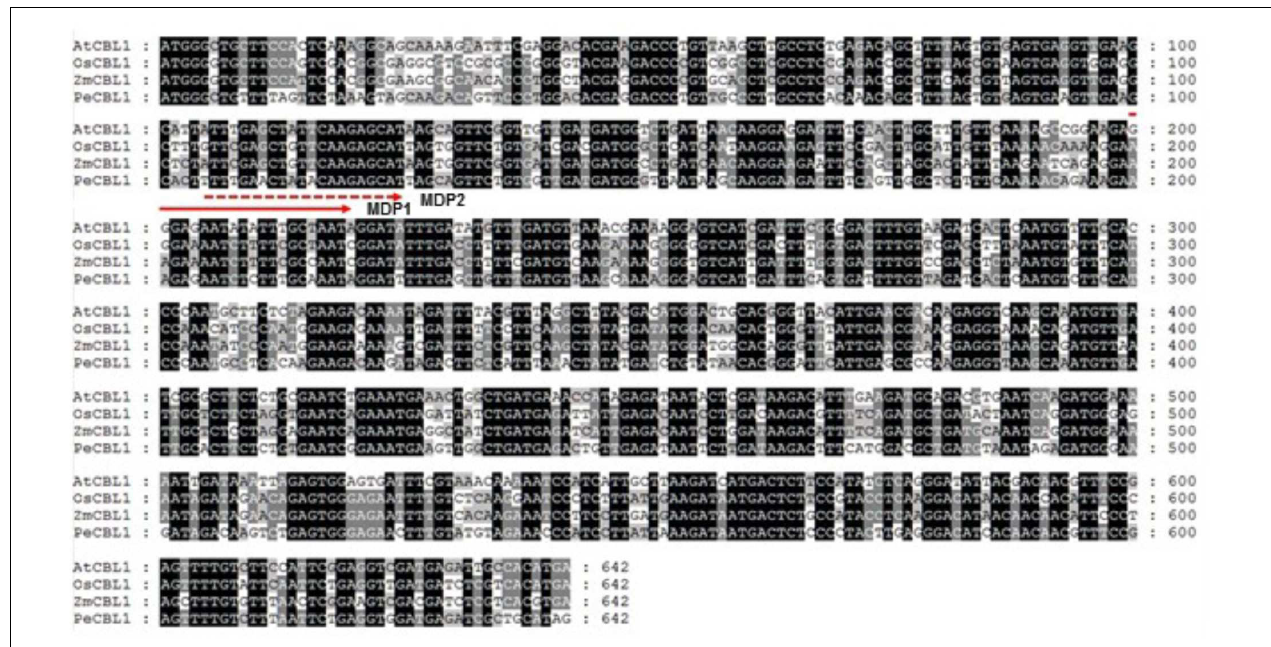
FIGURE 1 | Sequence alignment of CBL1 cDNAs from various plants. Nucleotide sequences of OsCBL1 (GenBank accession No. DQ201195), ZmCBL1 (EU907931), PeCBL1 (DQ337190) and AtCBL1 (AT4G17615) were aligned using Lasergene MegAlign Program (DNASTAR) and visualized with GeneDoc version 2.7. Nucleotides conserved in all four plant species are shaded black, and nucleotides conserved in 2–3 plants are shaded gray. The dashed and solid lines with an arrow indicate regions used to design two forward degenerative primers (MDP1 and MDP2) for 3 (cid:48) RACE.